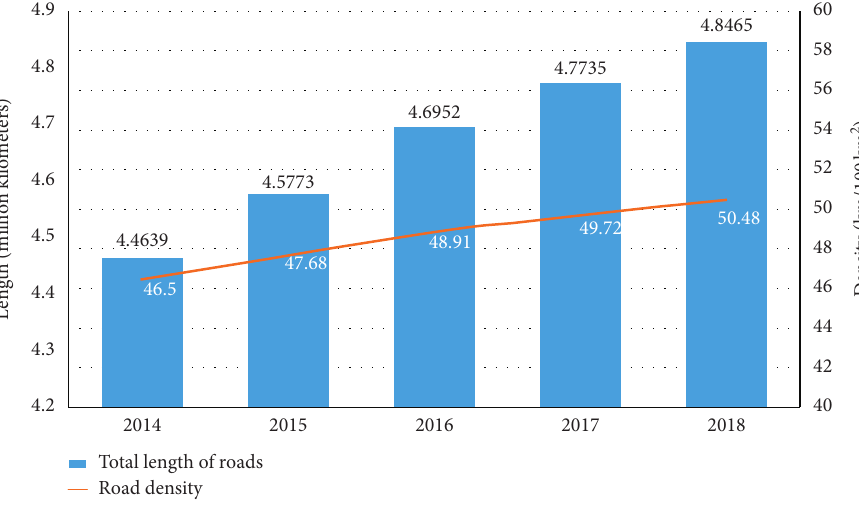
Figure 2: The total length and density of roads in China in the past five years.